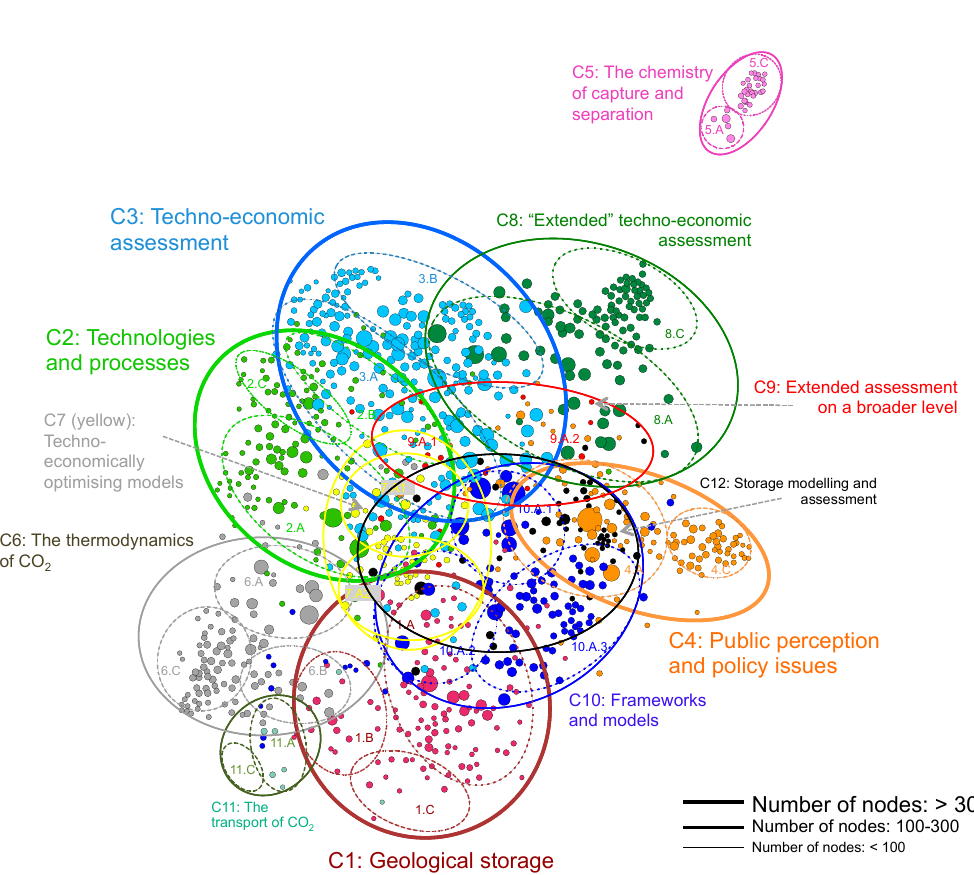
Figure 2. Schematic representation of the overall paper network, its 12 main clusters, and their sub-clusters. For the sake of clarity, only nodes with a degree > 50 are shown (1056 out of 4134 nodes); connections between nodes are not shown.